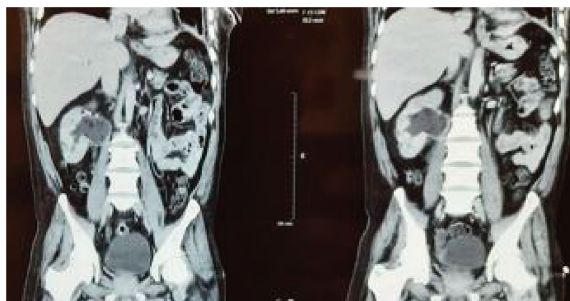
Figure 1: CT abdomen showed right-sided hydronephrosis.